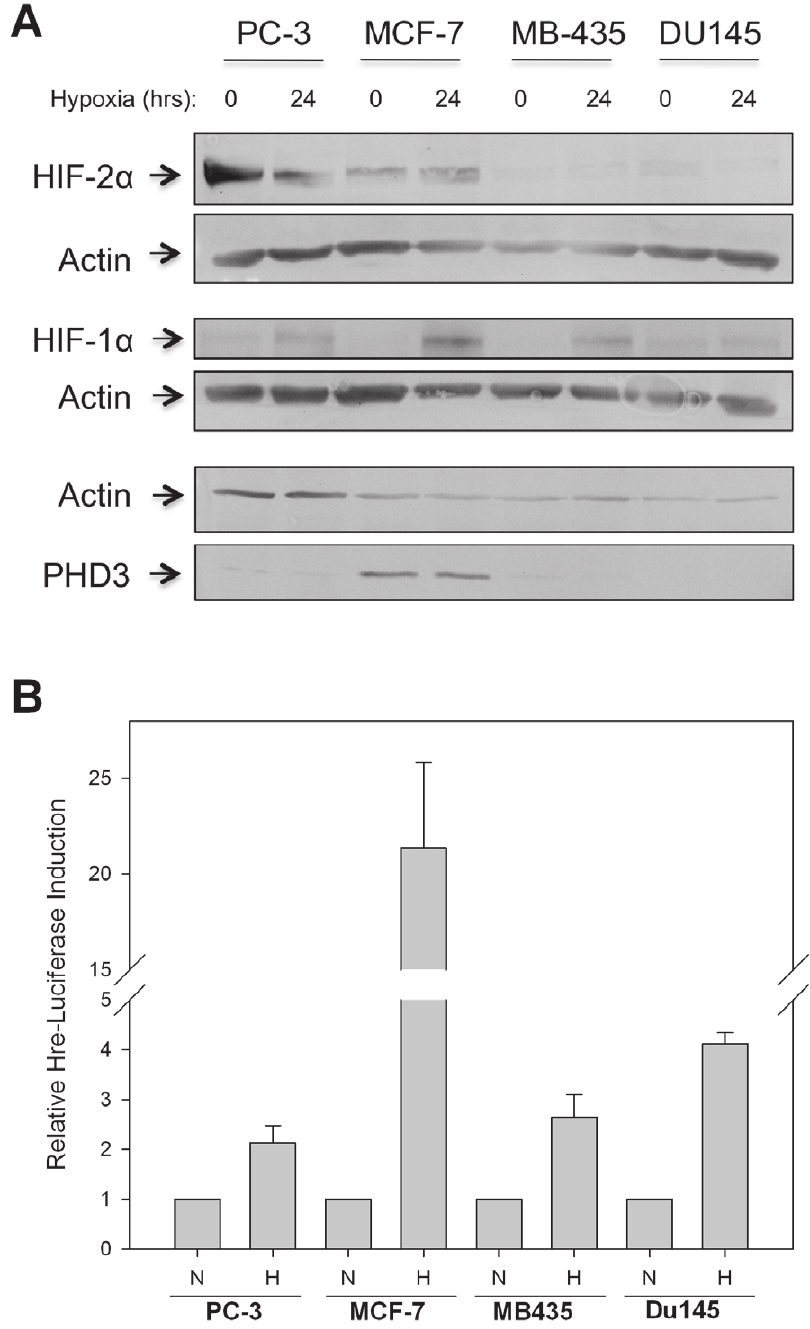
Figure 5. The HIF-1 response is not impaired in prostate and breast carcinoma cell lines that lack PHD3 . A ) Melanoma, breast and prostate cancer cell lines with methylated PHD3 promoters (MB-435, PC-3) and non-methylated promoters (MCF7, DU 145) were subjected to hypoxia (1% O 2 ) or normoxia for 24 hours. Thirty micrograms of whole cell lysate was western blotted for the presence of HIF-1 a , HIF-2 a and PHD3; actin was used as a loading control. B ) Breast and prostate cancer cell lines were transfected with an HRE-luciferase reporter vector and Renilla luciferase vector and then subjected to hypoxia (1% O 2 ) or normoxia for 24 hours. Luciferase activities after 24 hours of hypoxia were determined and are depicted relative to luciferase activities in cells under normoxia. Error bars = SEM. n=3 for MCF7 and PC-3. n=2 for MB-435 and DU 145. Probing for methylated CpGs in select tumor specimens using tumor sample 1 and tumor sample 4 did not detect any the MethylMiner kit indicated the possible presence of methylated CpGs (data not shown). This could be due to better methylated CpGs at the PHD3 CpG island in tumor sample 1 sensitivity to population average methylation states as com- ( Figure S4 ), which also contained the lowest PHD3 mRNA pared to the single molecule at a time approach of bisulfite levels. However, further bisulfite sequencing of 8 clones from sequencing.